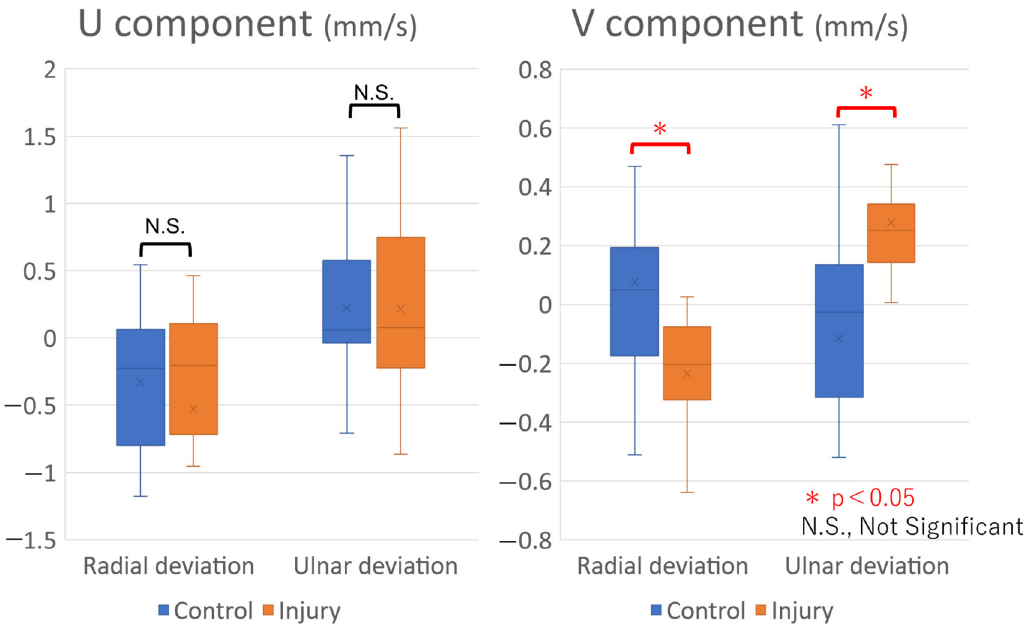
Figure 5. U and V components in the study groups. The U component was not significantly different between the two groups. The V component in the injury group was significantly higher than that in the control group during ulnar deviation.